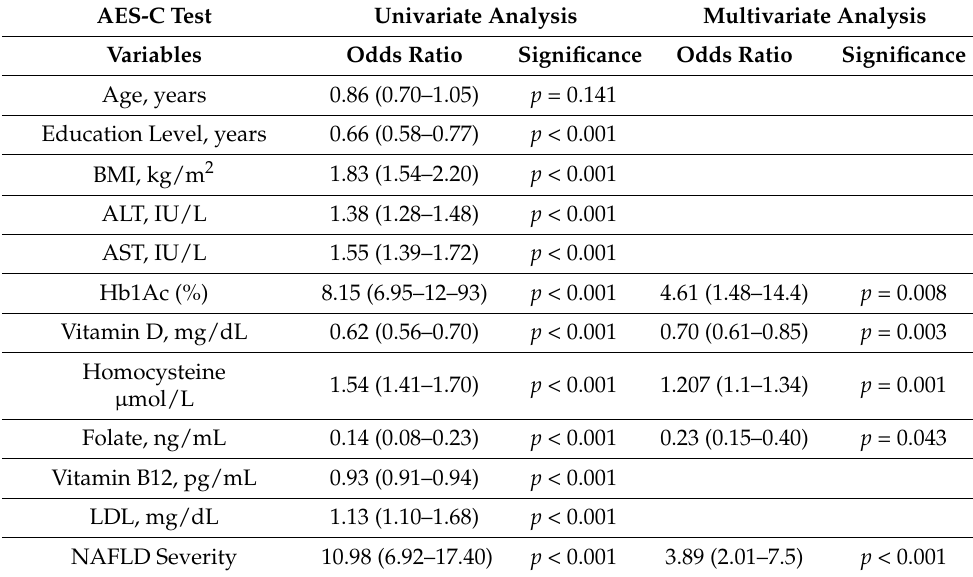
Table 6. Factors associated with worse AES-C test results in terms of Odds Ratio and its 95% C.I. Variables are initially studied univariately and then multivariately by choosing the model with the lowest BIC.